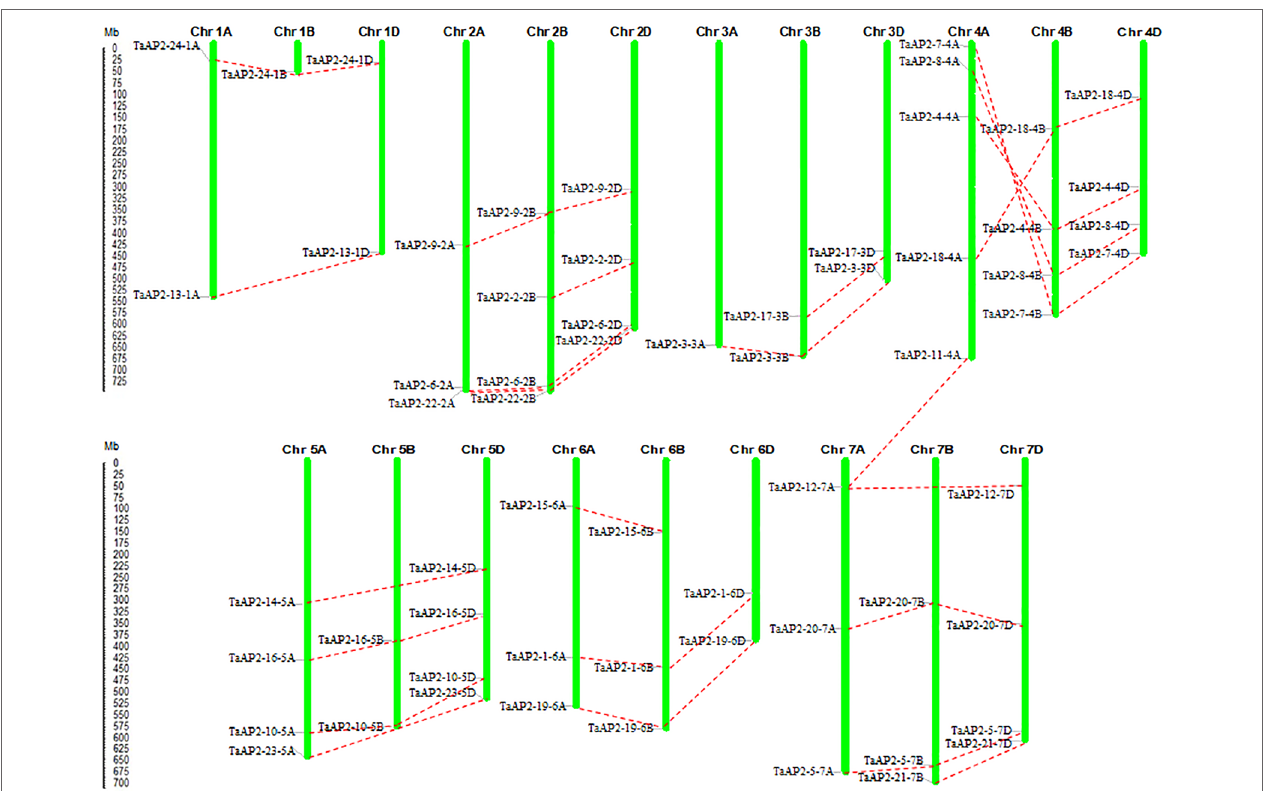
FIGURE 3 | Locations and duplication of the TaAP2 family genes on wheat chromosomes. The chromosomal position of each TaAP2 was mapped according to the physical positions of wheat genomes ( Table S2 ). The chromosome number is labeled at the top of each chromosome. The scale is in mega bases (Mb). Putative TaAP2 homologous genes are depicted through dotted